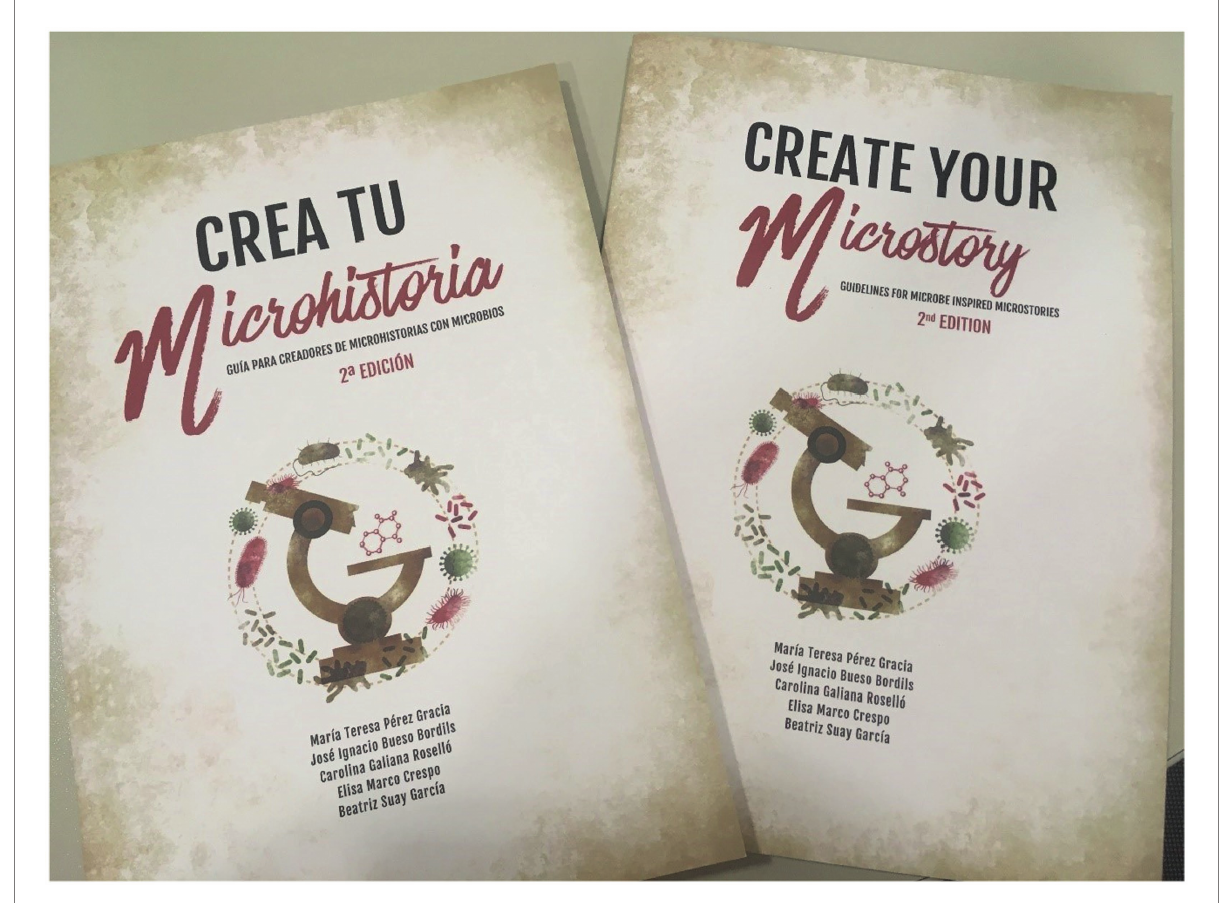
FIGURE 3 Second edition of “Create your microstory. Guidelines for microbe inspired microstories.”